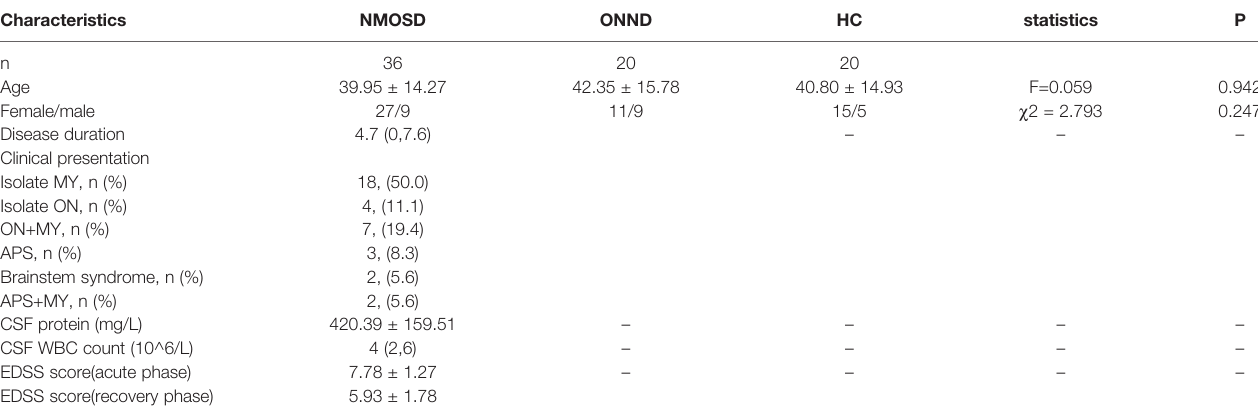
TABLE 1 | Demographic and clinical characteristics of patients in the NMOSD, ONND and HC groups.